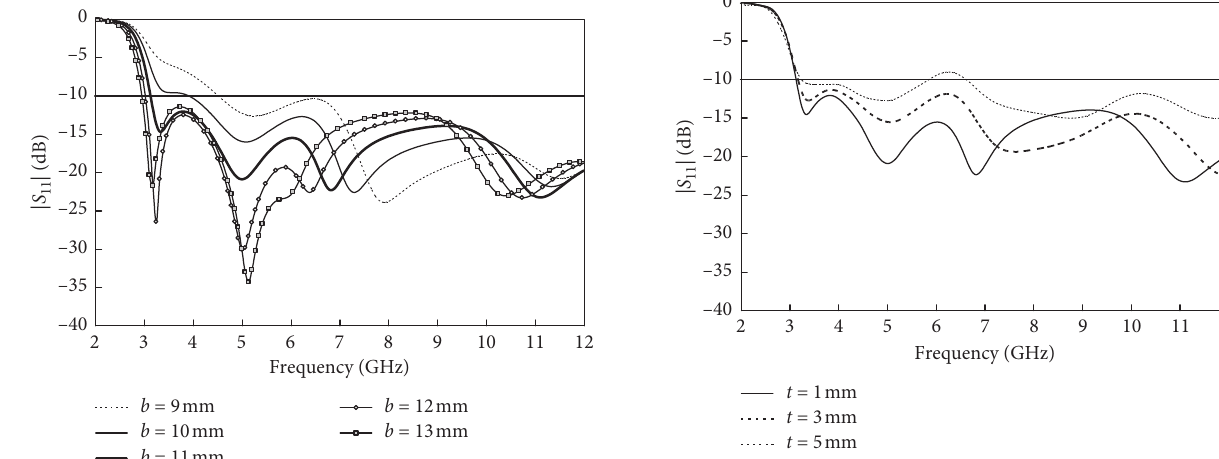
Figure 7: Simulated | S 11 | under varying t of 1, 3, and 5mm.